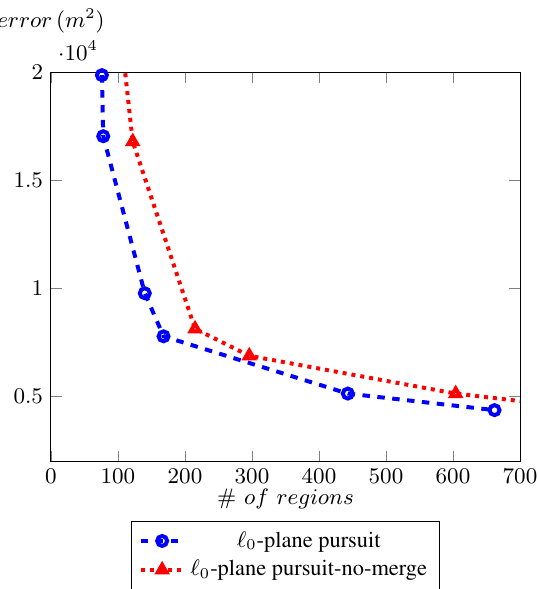
Figure 6. Comparison of the error between our method with and without the merge step on the chapel